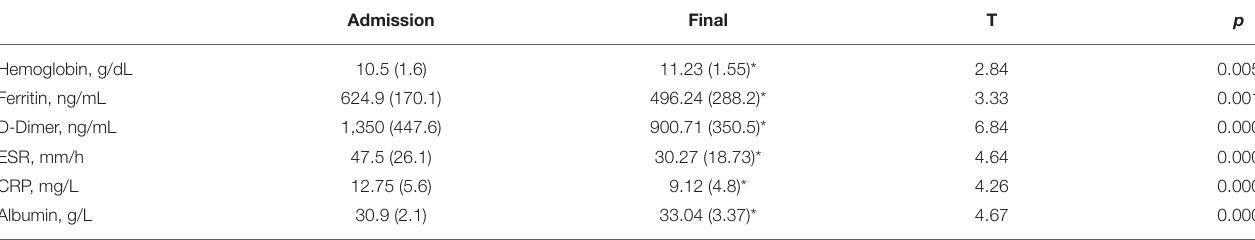
TABLE 3 | Comparison of main hematological data from all patients at hospital admission (Covid-19 acute phase) and 60 days from hospital discharge